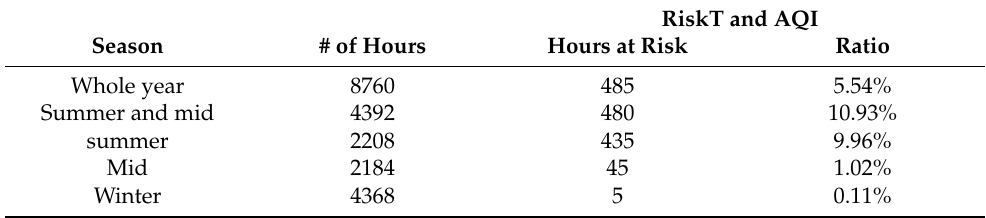
Table 5. Summary results of the allocated multi-hazard risk, when using AQI > 100 as the criterion, differentiated by